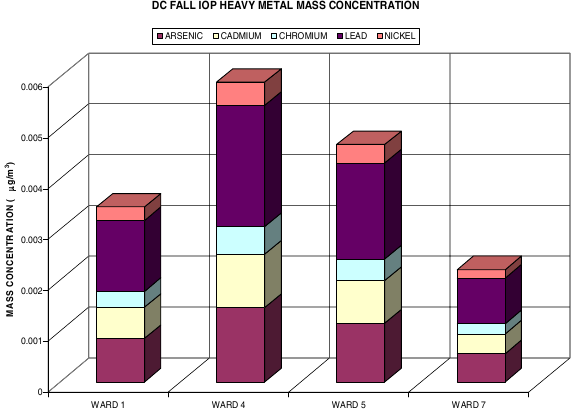
Figure 6: Heavy Metal Content for Fine PM during Fall